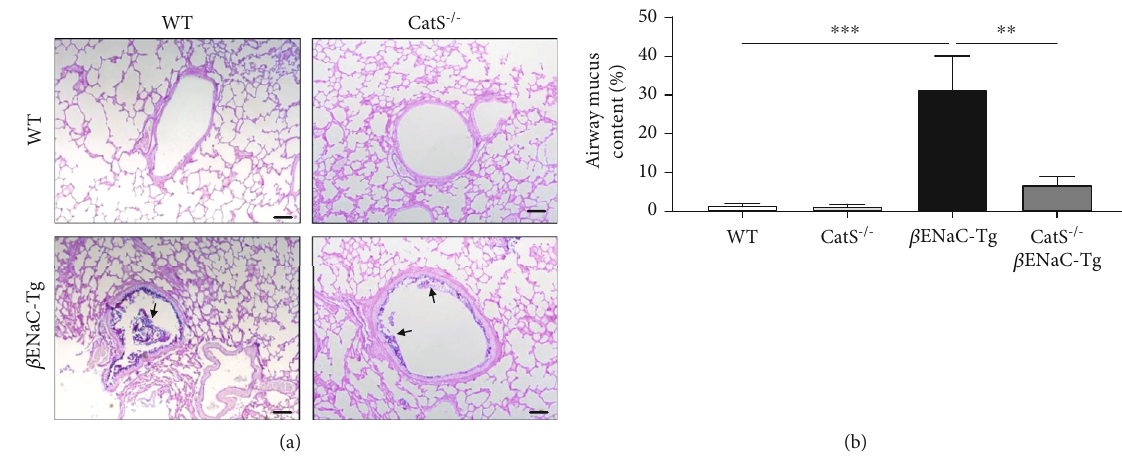
Figure 3: Cathepsin S knockdown from birth prevents mucus obstruction. (a) Representative images of adult WT, CatS -/- , β ENaC-Tg, and CatS -/- β ENaC-Tg mouse lung sections stained with Alcian blue-periodic acid Schi ff . Black arrows indicate airway mucus, scalebar = 100 μ m . (b) Airway mucus quanti fi cation is expressed as the percentage of the total airway area containing mucus ( n = 6 ‐ 7 group). ∗∗ P < 0 : 01 , ∗∗∗ P < 0 : 001 (one-way ANOVA with Tukey ’ s multiple comparisons